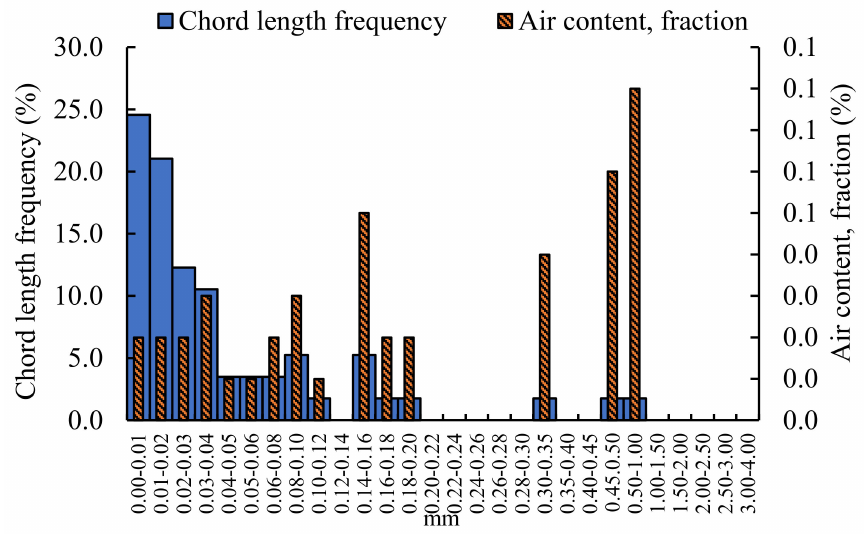
Figure 5. Analysis of pores structure of grouting material mixed with 1.2% NF.